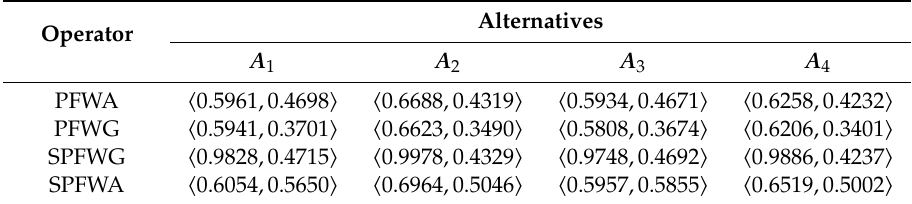
Table 3. The comprehensive evaluation values with di ff erent operators.